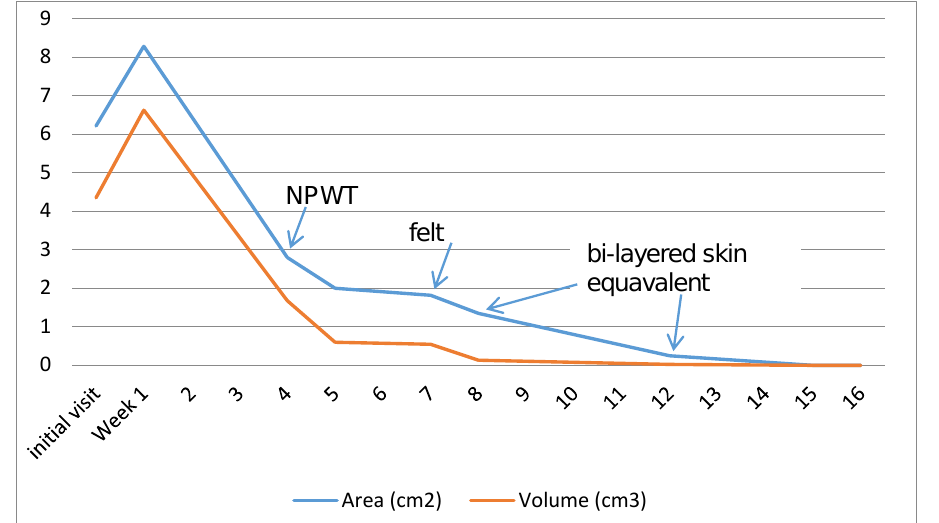
Figure 9. Appearance of wound at week 15.